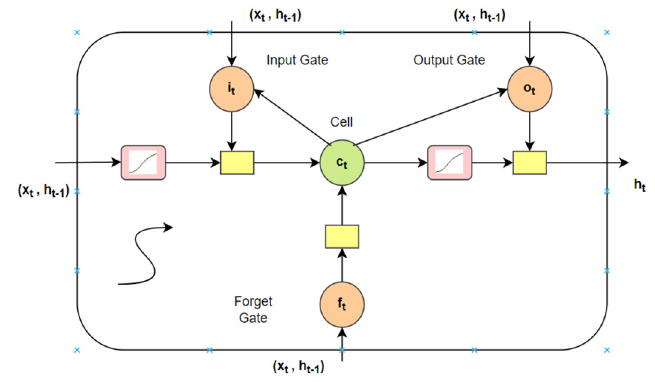
Figure 5. LSTM memory